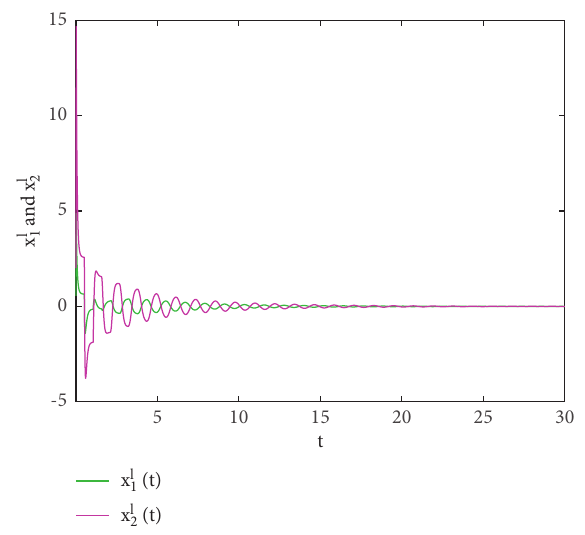
Figure 6: Imaginary parts of the transient states of system (68) under controller